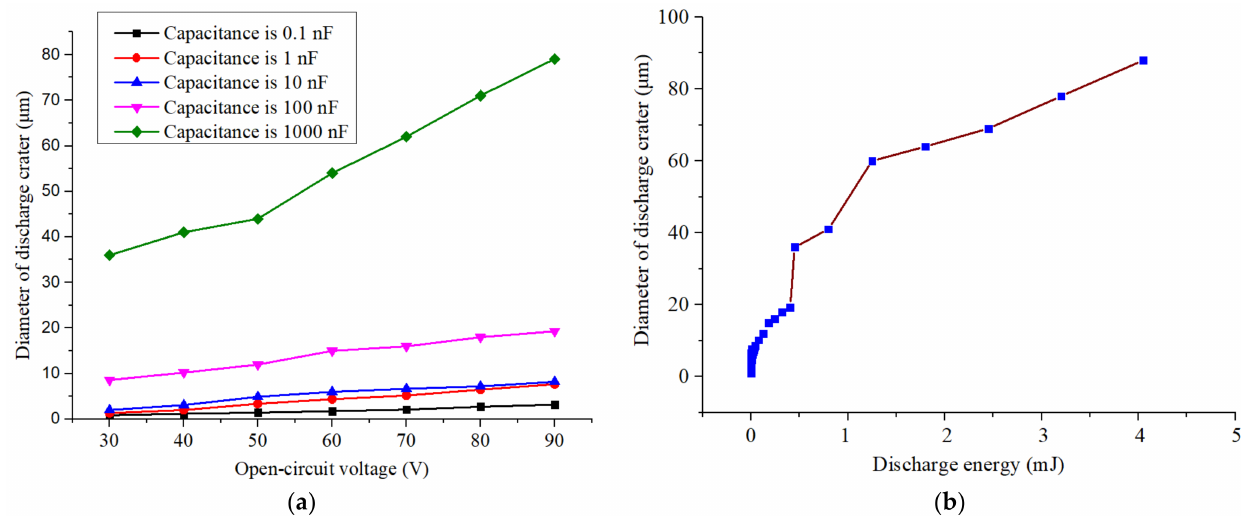
Figure 4. Effect of open-circuit voltage ( a ) and discharge energy ( b ) on the diameter of the discharge